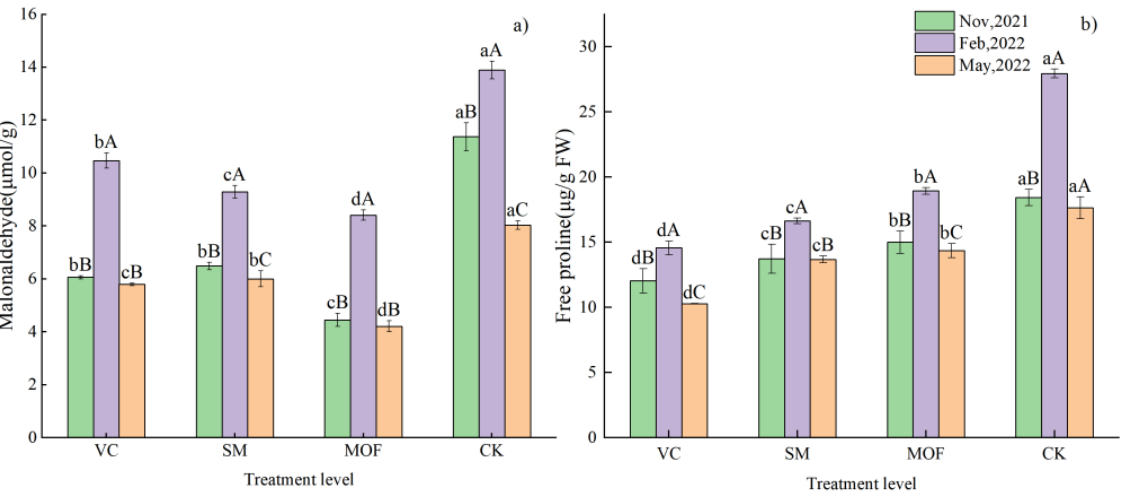
Figure 3. Effects of different bio-organic fertilizer treatments on Malonaldehyde and Free proline contents of “Qi-Nan” agarwood seedlings. ( a ) malonaldehyde; ( b ) free proline. No fertilizer (CK); vermicompost (VC); sheep manure (SM); microbial organic fertilizer (MOF). The bars were means ± standard error. Capital letters represent significant differences at the 0.05 level ( p ≤ 0.05) for the same treatment and different periods, and lowercase letters represent significant differences at the 0.05 level ( p ≤ 0.05) for the same period and different